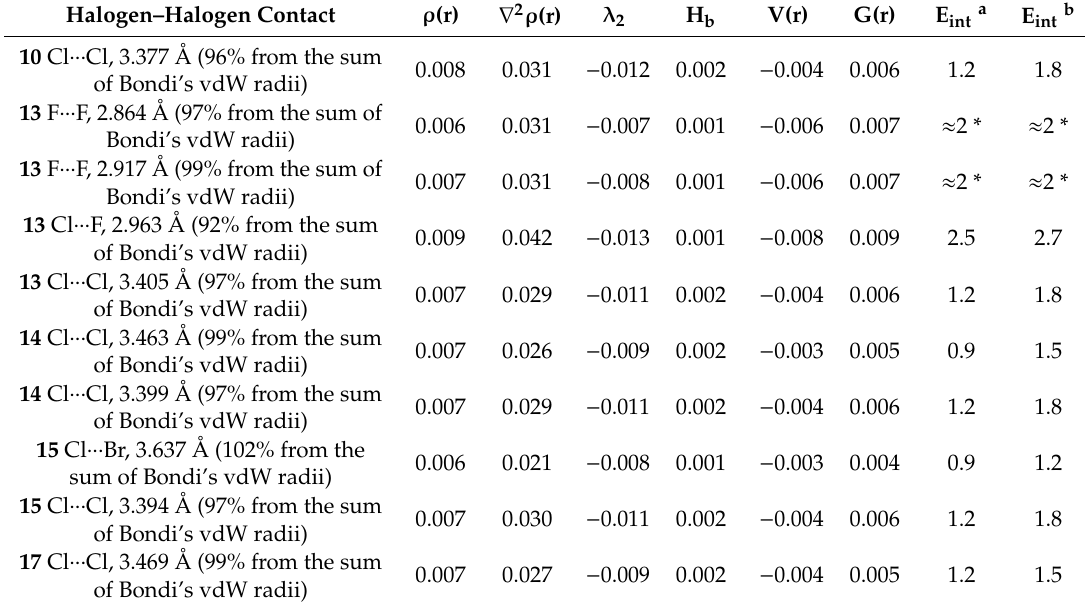
Table 1. Values of the density of all electrons— ρ (r), Laplacian of electron density— ∇ 2 ρ (r) and appropriate λ 2 eigenvalues (with promolecular approximation), energy density—H b , potential energy density—V(r), and Lagrangian kinetic energy—G(r) (a.u.) at the bond critical points (3, − 1), corresponding to various short halogen-halogen contacts in 10 , 13 – 15 , and 17 , and estimated energies for these interactions E int (kcal /